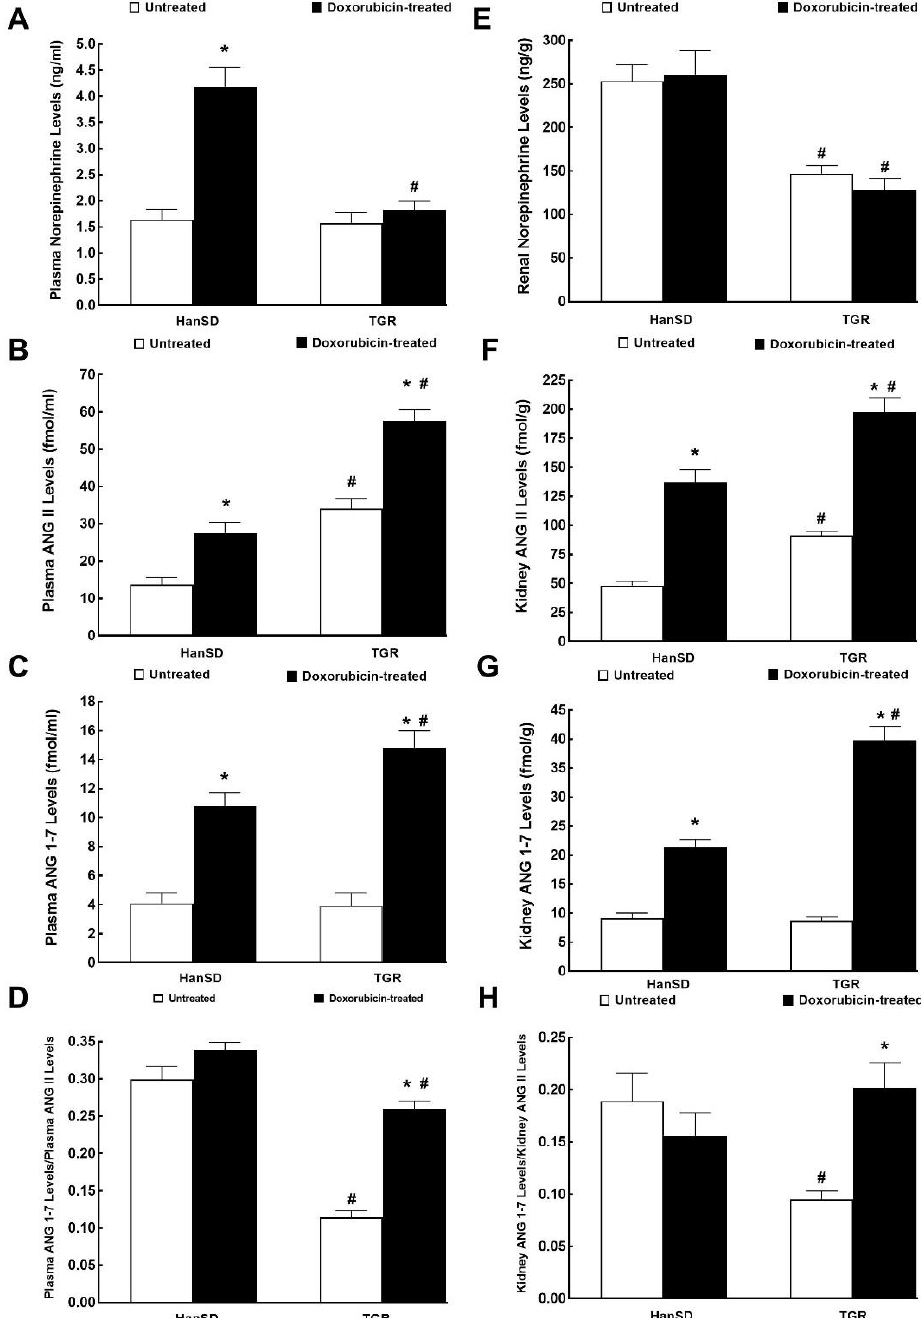
Figure 9. Plasma and kidney biochemical parameters. Plasma and kidney norepinephrine ( A , E ), angiotensin II (ANG II) ( B , F ), angiotensin 1-7 (ANG 1-7) ( C , G ) levels and the ratio of ANG 1-7 to ANG II ( D , H ) after the last doxorubicin injection (i.e., at the end of experimental protocol) in normotensive, transgene-negative Hannover Sprague-Dawley (HanSD) and hypertensive, Ren-2 transgenic (TGR) rats. * p < 0.05 compared with untreated animals of the same strain. # p < 0.05 versus HanSD rats exposed to the same protocol. The values are means ± SEM.